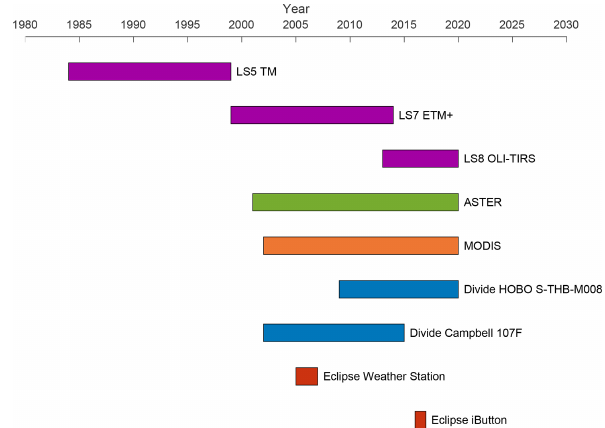
Figure 3. Temporal coverage of datasets used in this study. Time pe- riods covered are 1984–present (LS5 TM, Thematic Mapper; LS7 ETM+, Enhanced Thematic Mapper Plus; and LS8 OLI-TIRS, Op- erational Land Imager–Thermal Infrared Sensor; together referred to as “Landsat”), 2001–present (ASTER), 2002–present (Divide HOBO S-THB-M008 and Divide Campbell 107F; together referred to as “Divide AWS”), 2002–present (MODIS), 2005–2007 (Eclipse weather station), and 2016–2017 (Eclipse iButton). The Eclipse weather station and iButton are together referred to “Eclipse